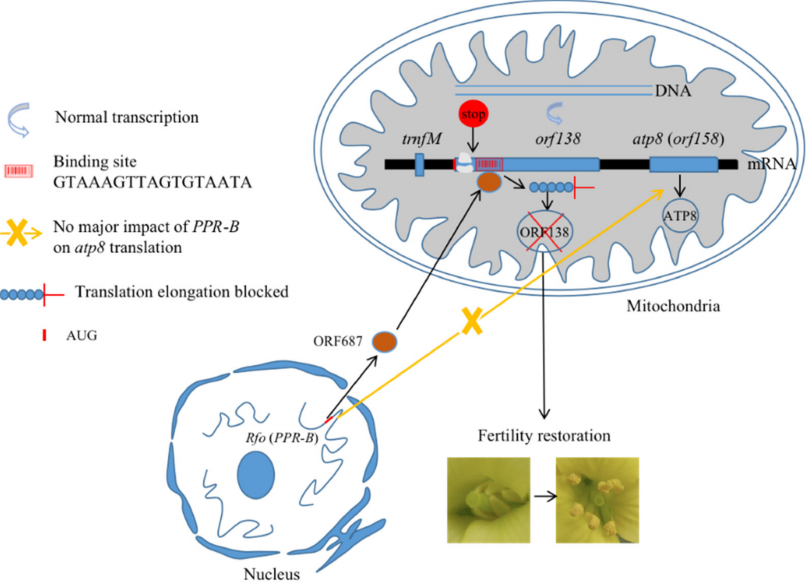
Figure 3. Model of the mechanisms of the Ogura CMS fertility restorer gene Rfo ( PPR-B ) (Wang et al.,